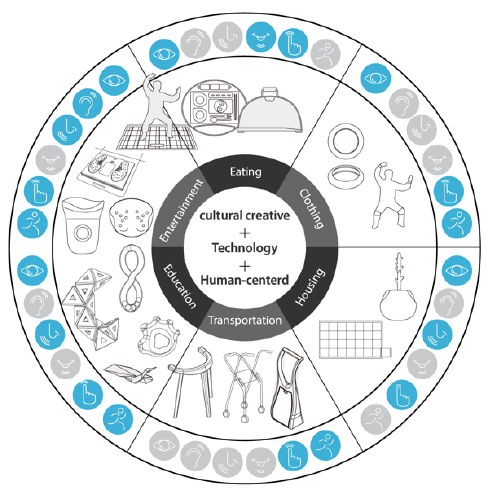
Figure 2. Conceptual design of assistive devices